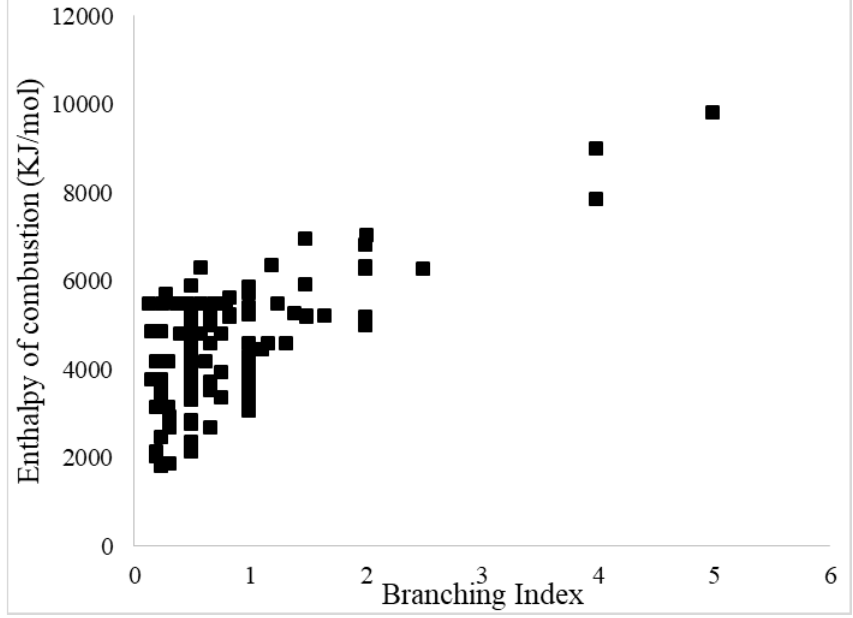
Figure 18. The effect of branching index on enthalpy of combustion for all collected data .